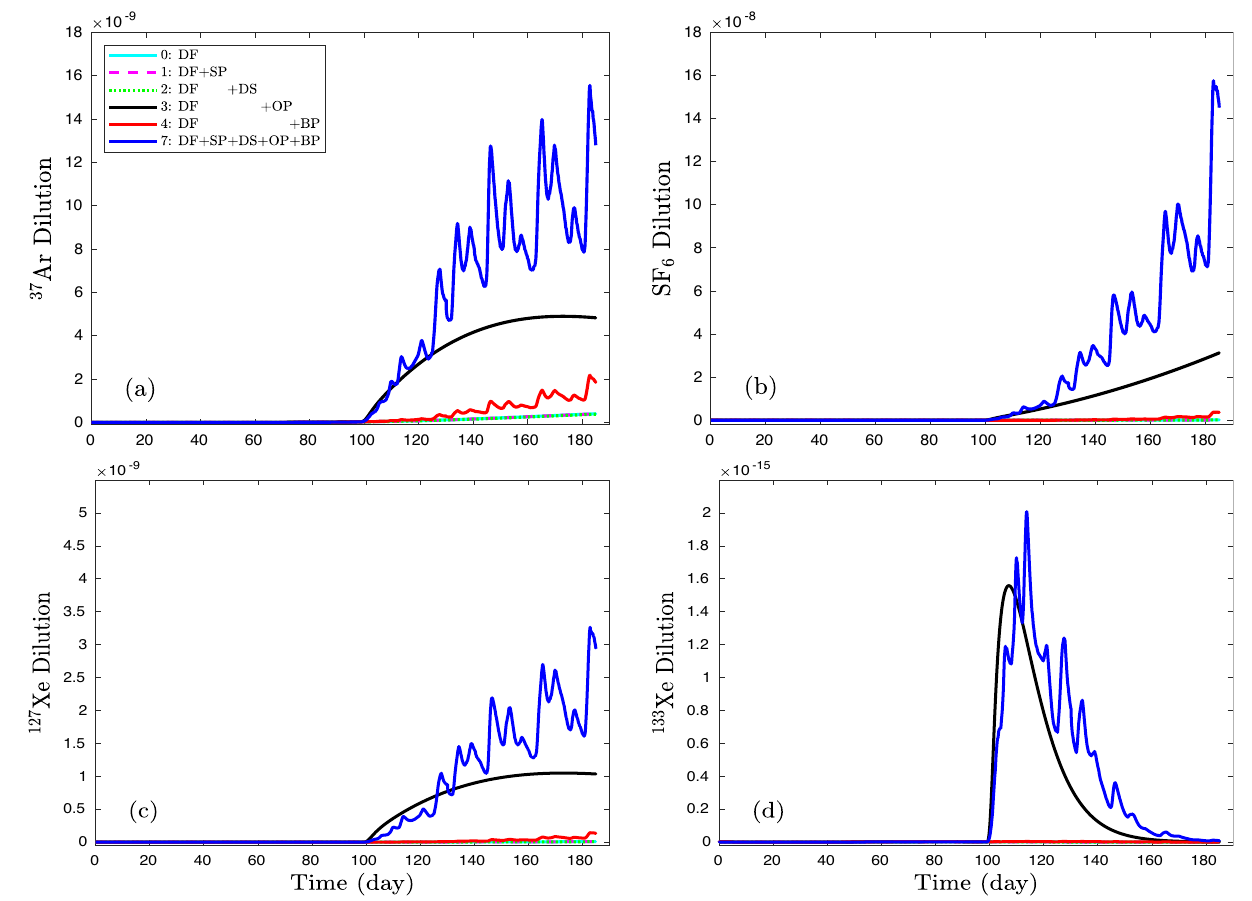
37 127 133 Ar, ( b ) SF 6 , ( c ) Xe, and ( d ) Xe at the depth of 0.5 m